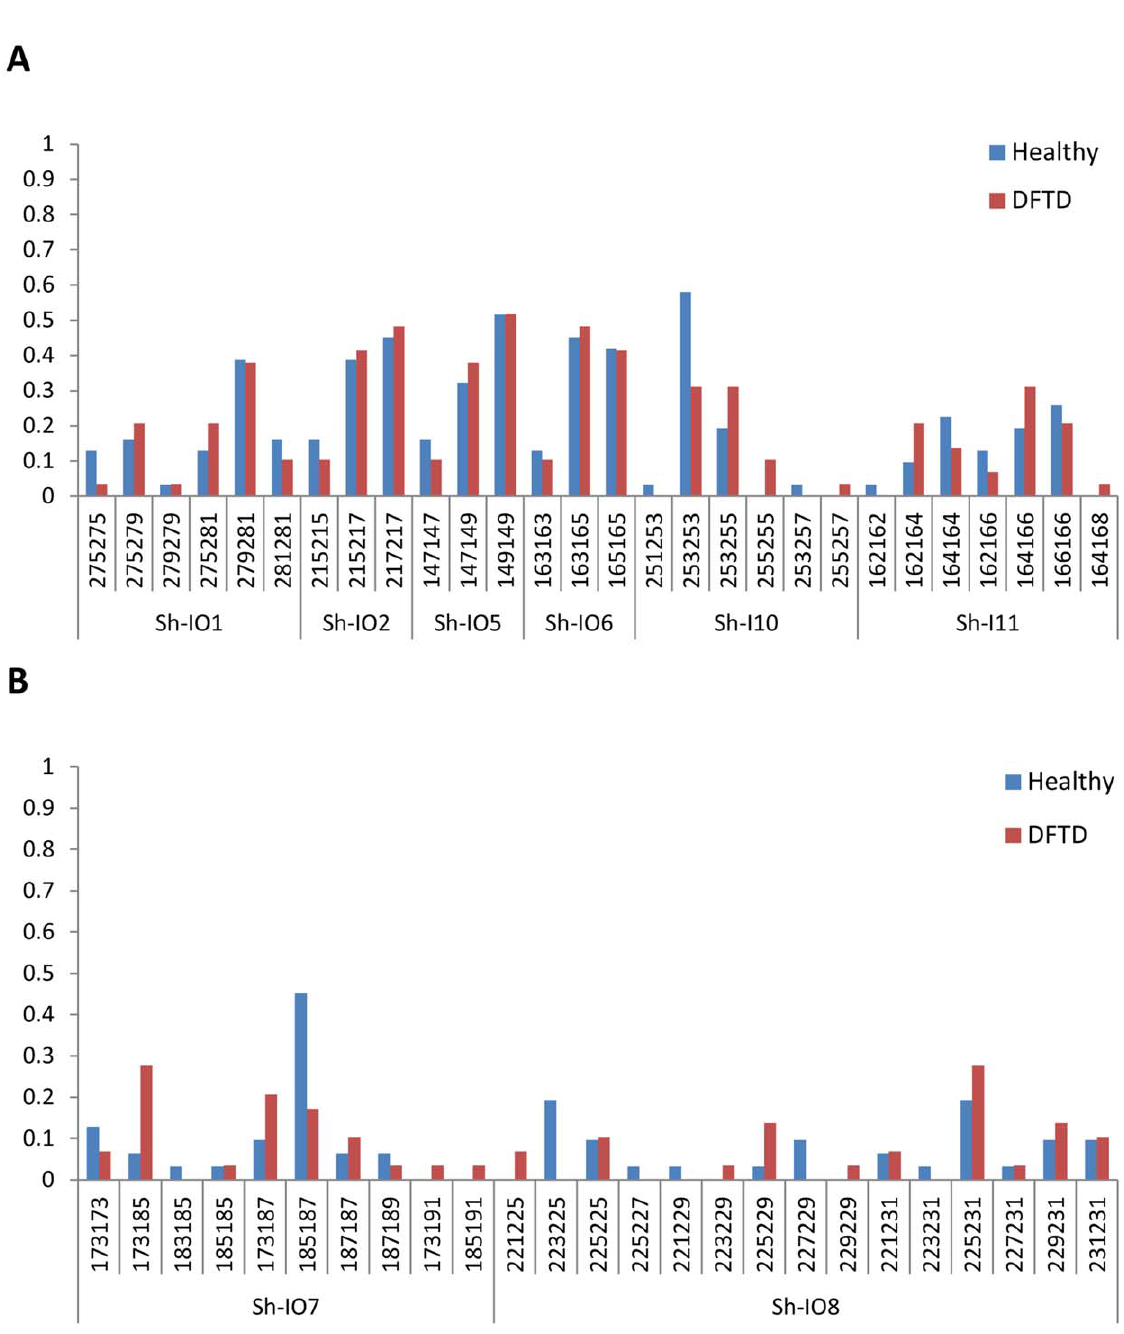
healthy and diseased devils. Three differences were identified in genotype frequency at two separate loci, which were significant before sequential Bonferroni correction (Sh-I07 genotype 173/ 185, p =0.041 and 185/187, p =0.024; Sh-I08 genotype 223/225, p = 0.024: Fig. 3b), though not afterwards due to the large number of comparisons. These differences warrant further investigation,